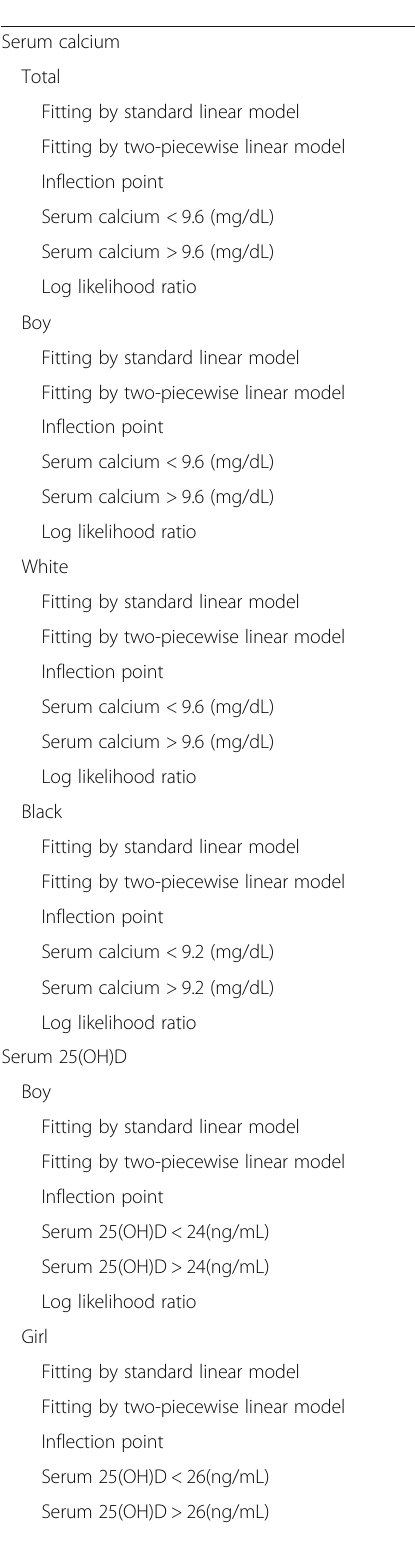
Table 4 Threshold effect analysis of serum calcium and 25(OH)D on total bone mineral density by using two-piecewise linear